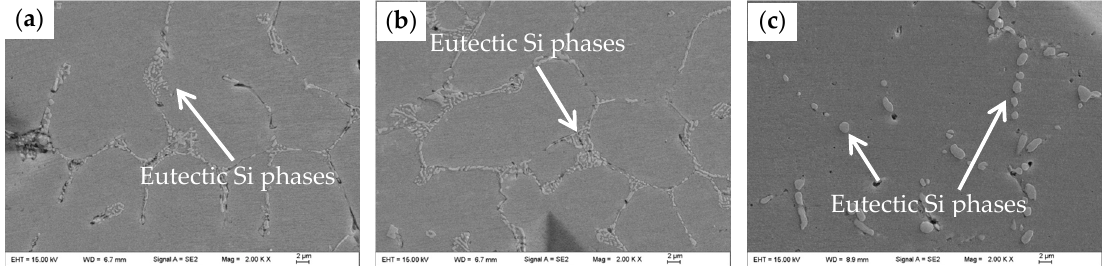
Figure 14. SEM microstructures of the weld center of welded joint No. 2 with different kinds of PWHTs: ( a ) AW; ( b ) AG; ( c ) SAG. Table 6. Component analysis of a tungsten inert gas (TIG) welded joint by spectrometry (Points ① – ④ seen in Figure 15).